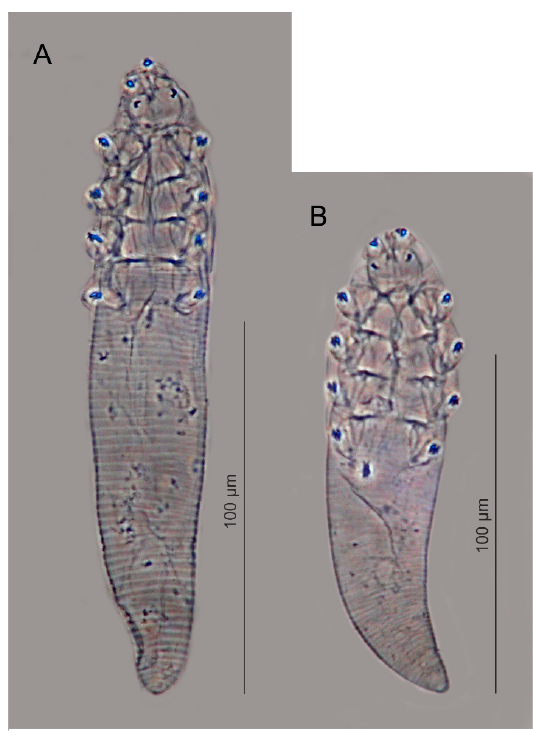
Figure 1. Demodex sciurinus : ( A ) female. ( B ) male.